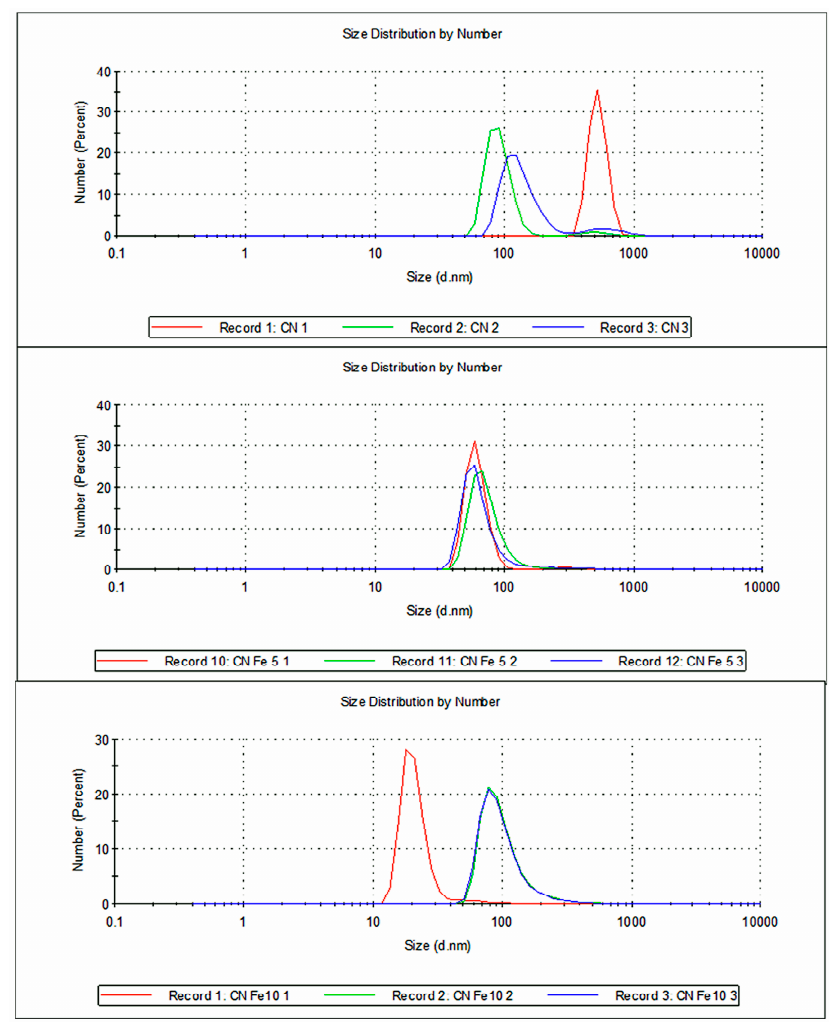
Figure 3. Size distribution of ( a ) CNF; ( b ) CN ‐ Fe 5 %; and ( c ) CNF ‐ Fe 10 %.